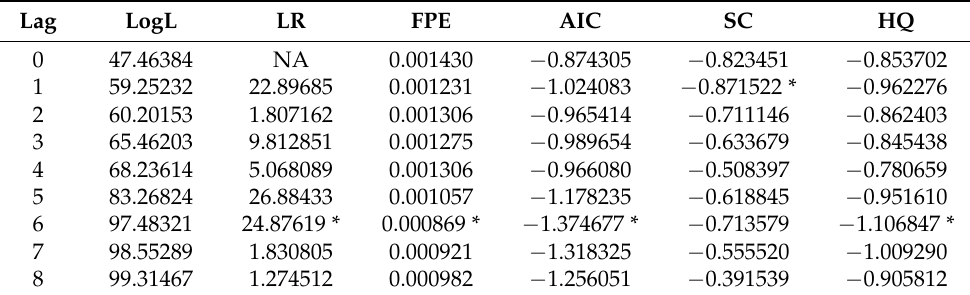
Table 5. Test for selection number of lags.